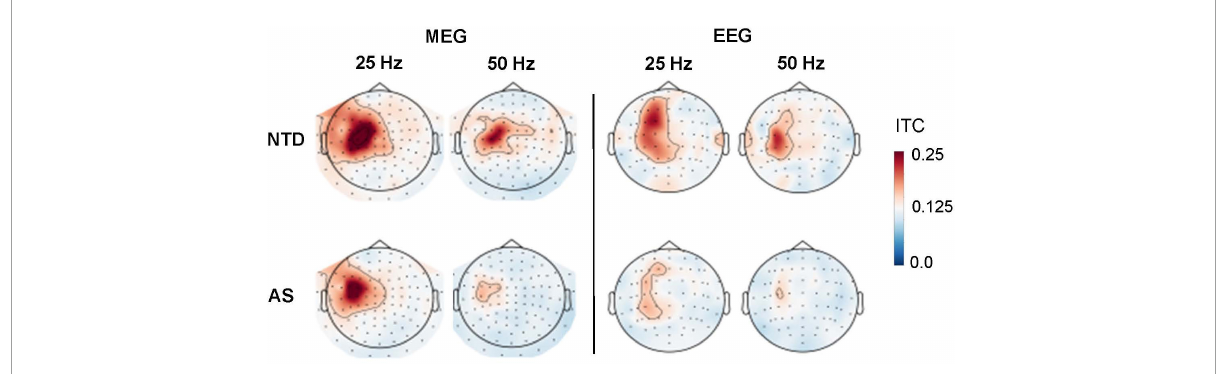
FIGURE2 Topographic maps of the Inter-trial coherence (ITC) at 25 and 50 Hz in MEG gradiometers ( left ) and EEG sensors ( right ) for NTD ( top ) and AS ( bottom ) groups. The ITC values were averaged over the 250–1,000 ms post-stimulus-onset time window. The small dots indicate sensor locations.